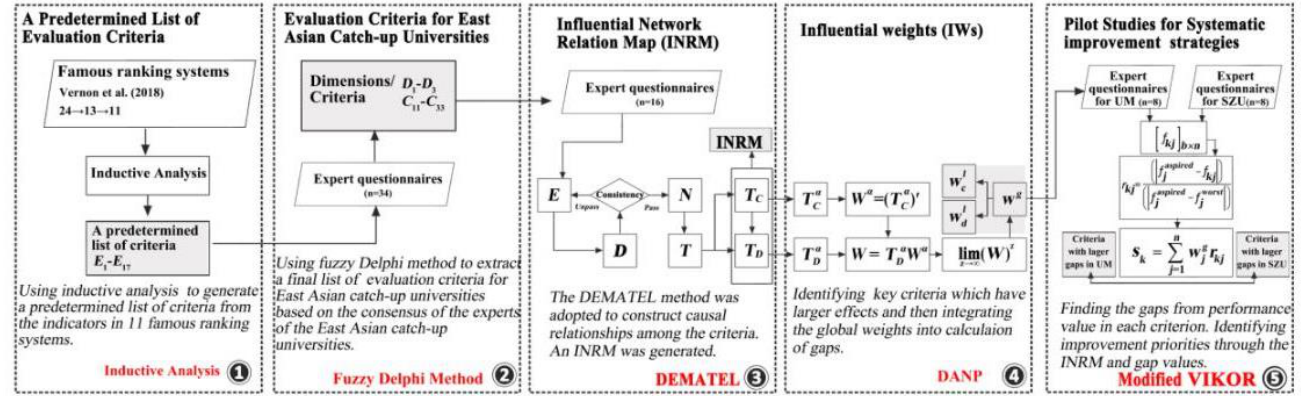
Figure 1. Framework of the proposed model.